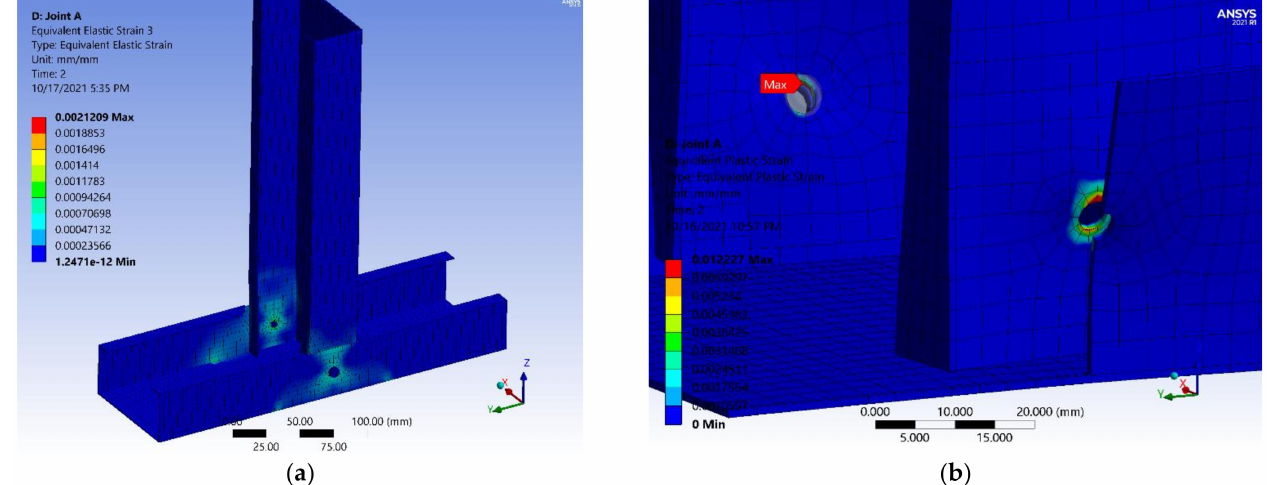
Figure 25. Equivalent strain distribution joint A: ( a ) overall equivalent elastic strain; ( b ) detail near hole and screws area of equivalent plastic strain.